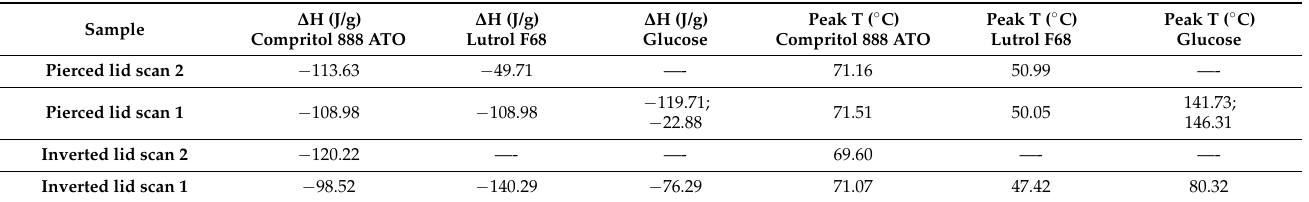
Table 3. Enthalpy variations ( ∆ H) and peak temperatures of the first scan and second scan of G 1 lyophilized SLN obtained through inverted lid and pierced lid procedures.